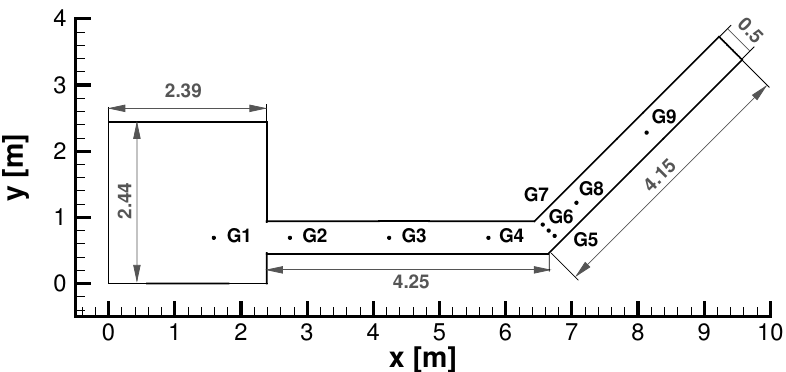
Figure 25. Computational domain and wave gauges locations for the 3D CADAM test